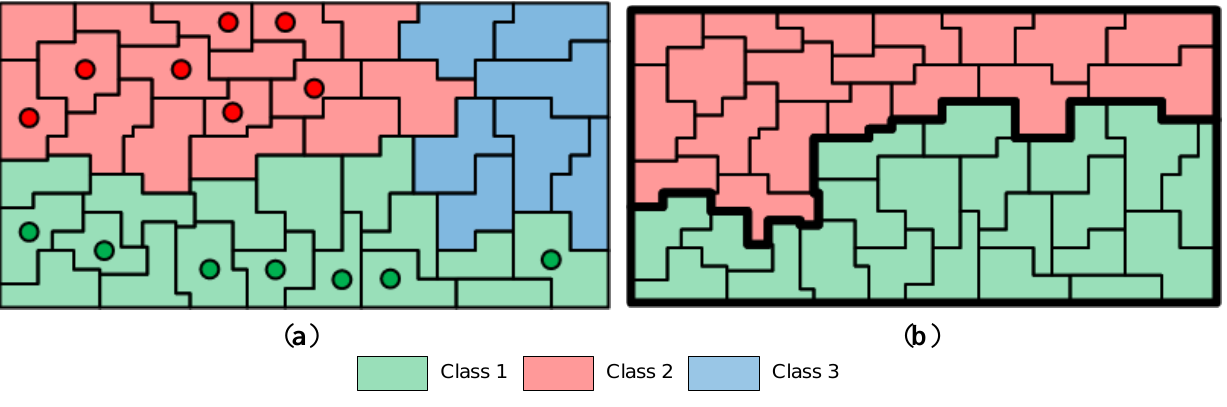
Figure 2. ( a ) An example of initial map of labeled CCs with illustration of marked watersheds, ( b ) Possible segmentation of the same area after